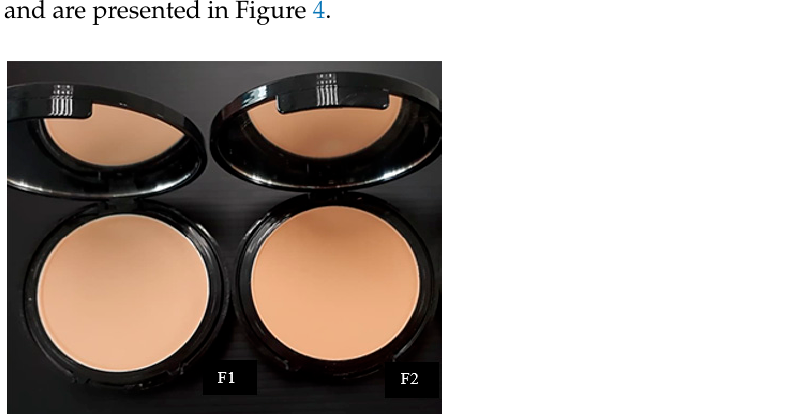
Figure 5. The appearance of the puffs for the pay-off test: the talcum compact powder (F1) and rice flour replaced talcum (F2). 3.6. Breakage Test The adhesive property of powders with the puff of the developed products was ob- served and we found that both products presented a highly adhesive property (Figure 6). After drop testing, the talcum-compact powder (F1) and the modified rice flour compact powder (F2) slightly cracked under an optimum compressive strength of 10 bars, as shown in Figure 6. Figure 6. The appearance of the puffs for the breakage test: the talcum-compact powder (F1) and the modified rice flour replaced talcum (F2). F1